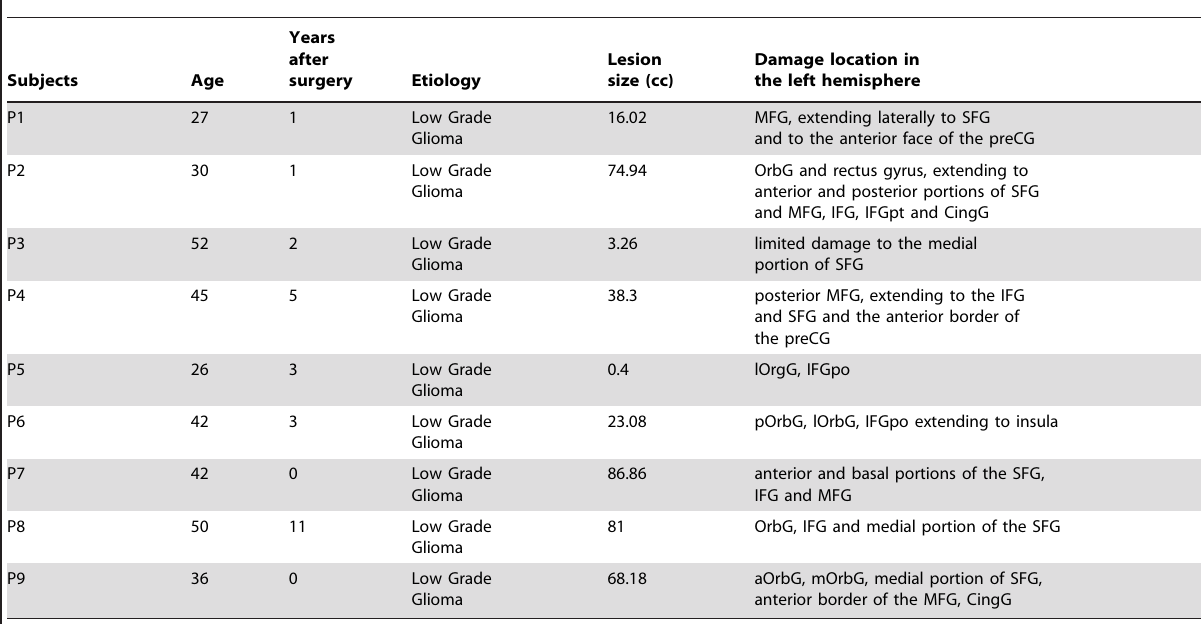
Table 1. Age, lesion size and location for each individual LFL patient.